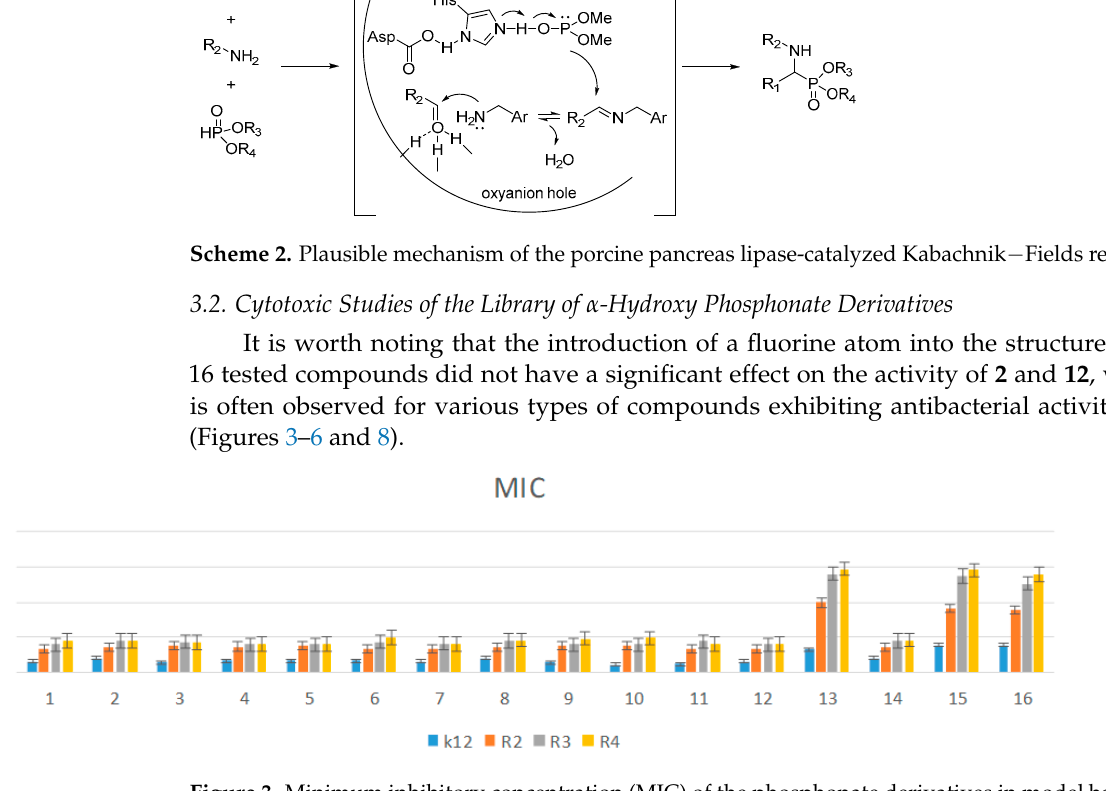
Figure 3. Minimum inhibitory concentration (MIC) of the phosphonate derivatives in model bacterial strains. The x -axis features compounds 1 – 16 used sequentially. The y -axis shows the MIC value in µg/mL − 1 . Investigated strains of E. coli K12 as the control (blue), R2 strains (orange), R3 strains (grey), and R4 strains (yellow). The order in which the compounds were applied to the plate is shown in Supplementary Materials Figure S1.